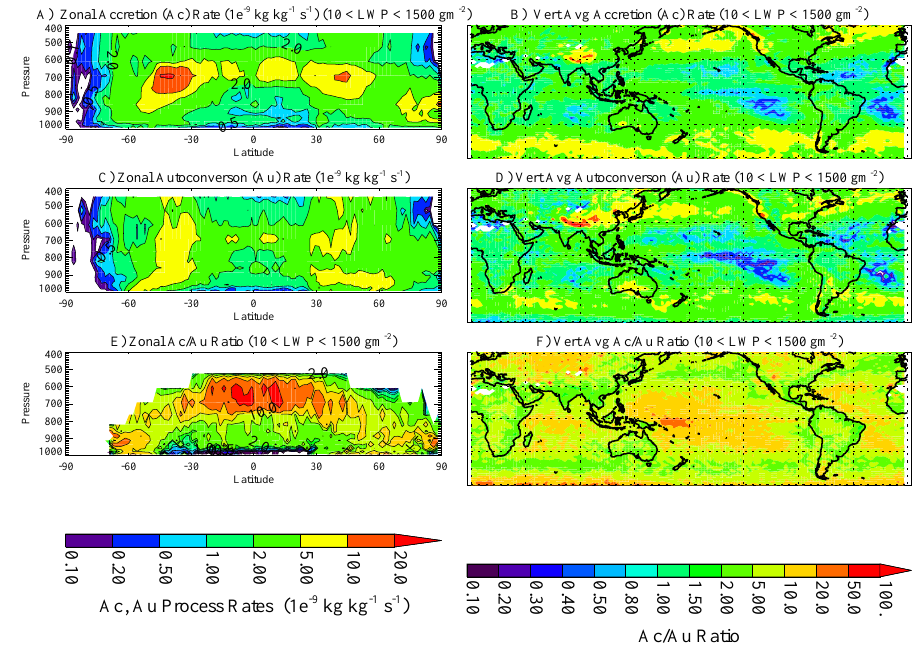
Fig. 4. Zonal mean latitude height (A, C, E) and vertically averaged maps (B, D, F) of accretion rate ( A c : A, B ), autoconversion rate ( A u : C, D ), and the ratio of accretion to autoconversion rate ( A c /A u : E, F ) for all